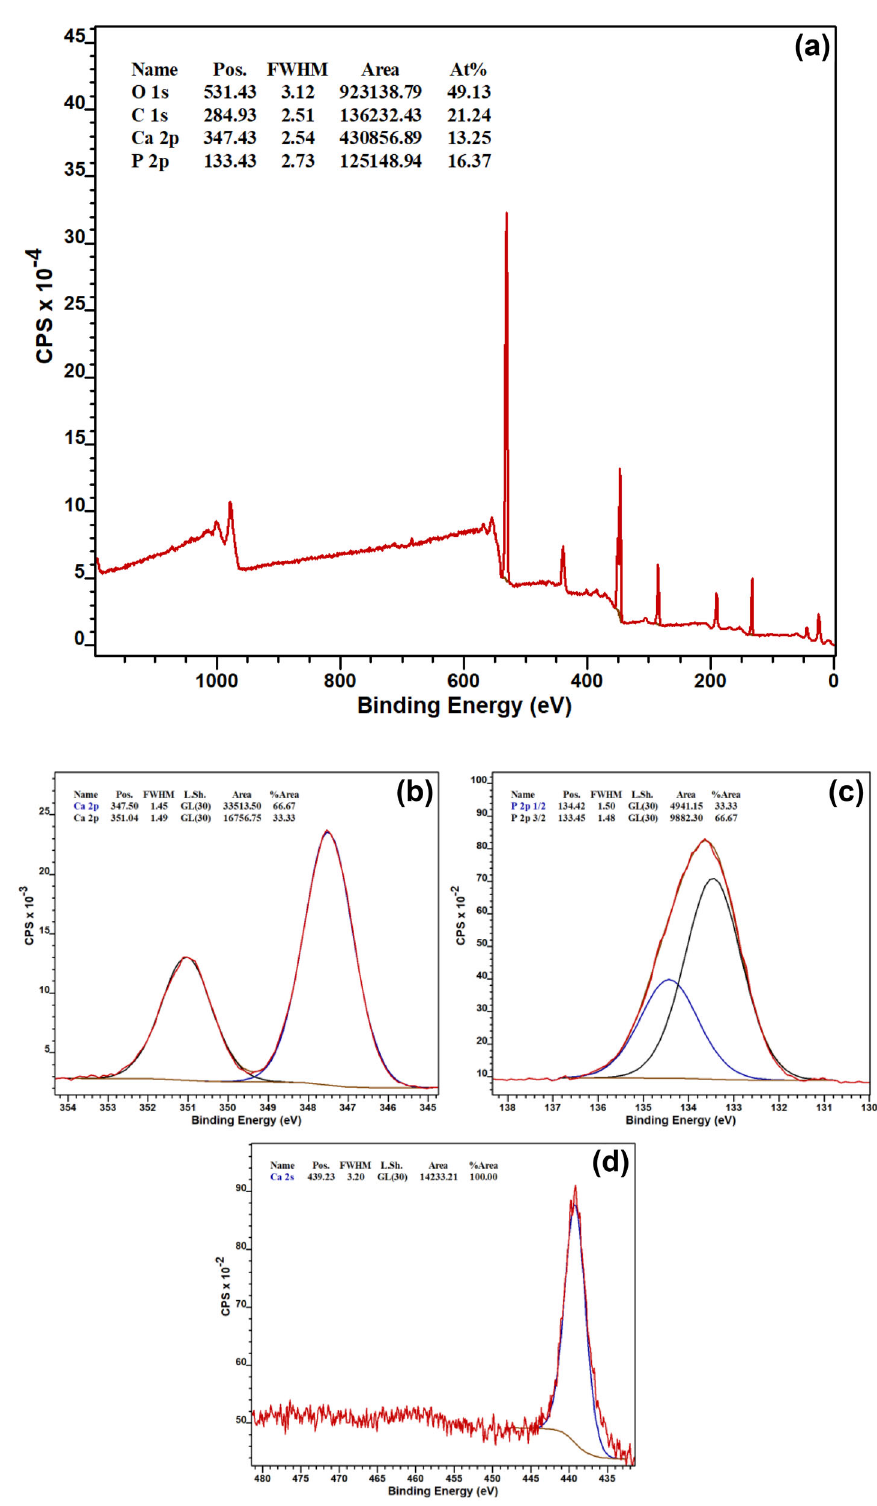
Fig. 1 a XPS WESS from one random location on HA-coated Ti substrate. XPS high resolution scans for elemental orbitals b Ca 2p, c P 2p, and d Ti 2p from one random location on HA-coated Ti